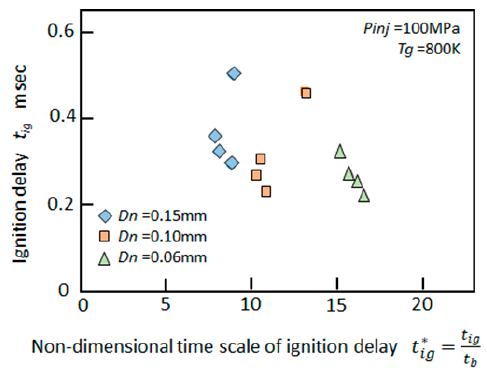
Figure 30. Non-dimensional timescale of ignition delay.